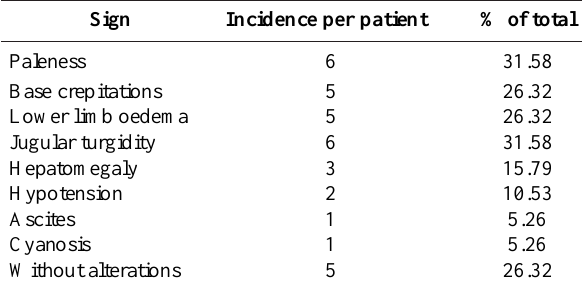
Table 2. Most prevalent signs in patients with cardiac tumours Sign Incidence per patient